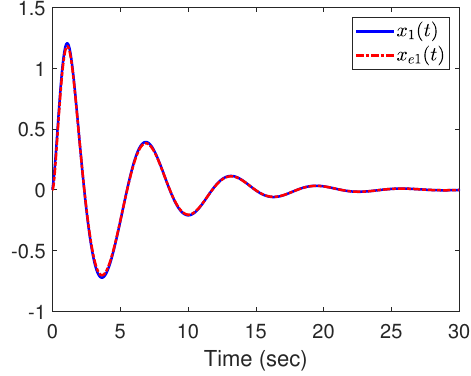
Figure 2. The trajectories of x 1 ( t ) and x e 1 ( t ) .